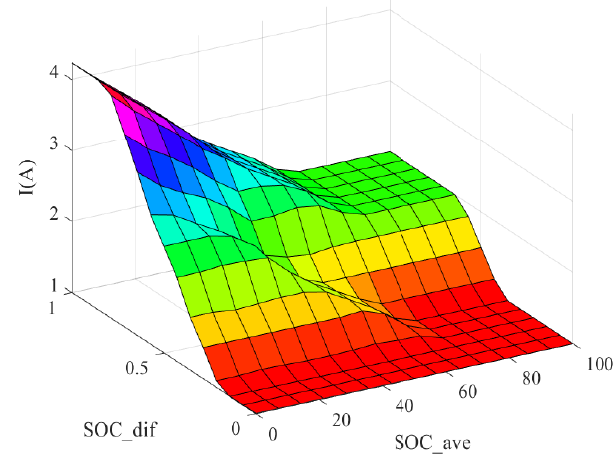
Figure 9. Three-dimensional relational surfaces.